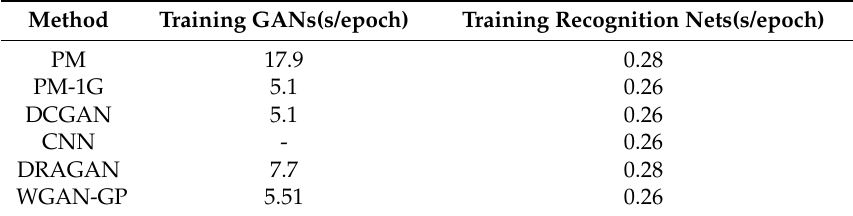
Table 6. The training time of our network, supervised CNN, DCGAN, DRAGAN, and WGAN-GP trained by 600 labeled